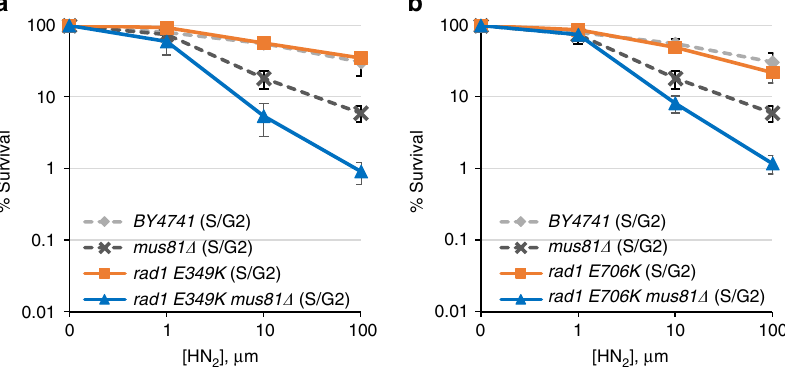
Fig. 5 Sensitivity to HN 2 treatment of cells expressing rad1-E349K ( a ) and rad1-E706K ( b ) mutants and mus81 deletion. Cells were arrested in G1 by α - factor treatment and released into medium with the indicated concentrations of HN 2 before plating. Error bars are average ± s.d. of three independent experiments